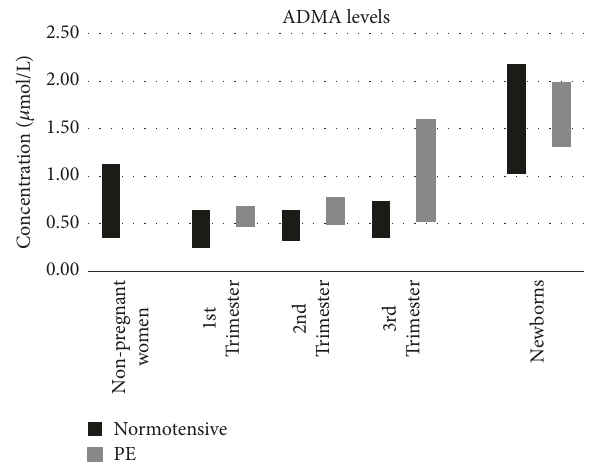
Figure 12: Levels of ADMA throughout pregnancy as compared to levels in nonpregnant